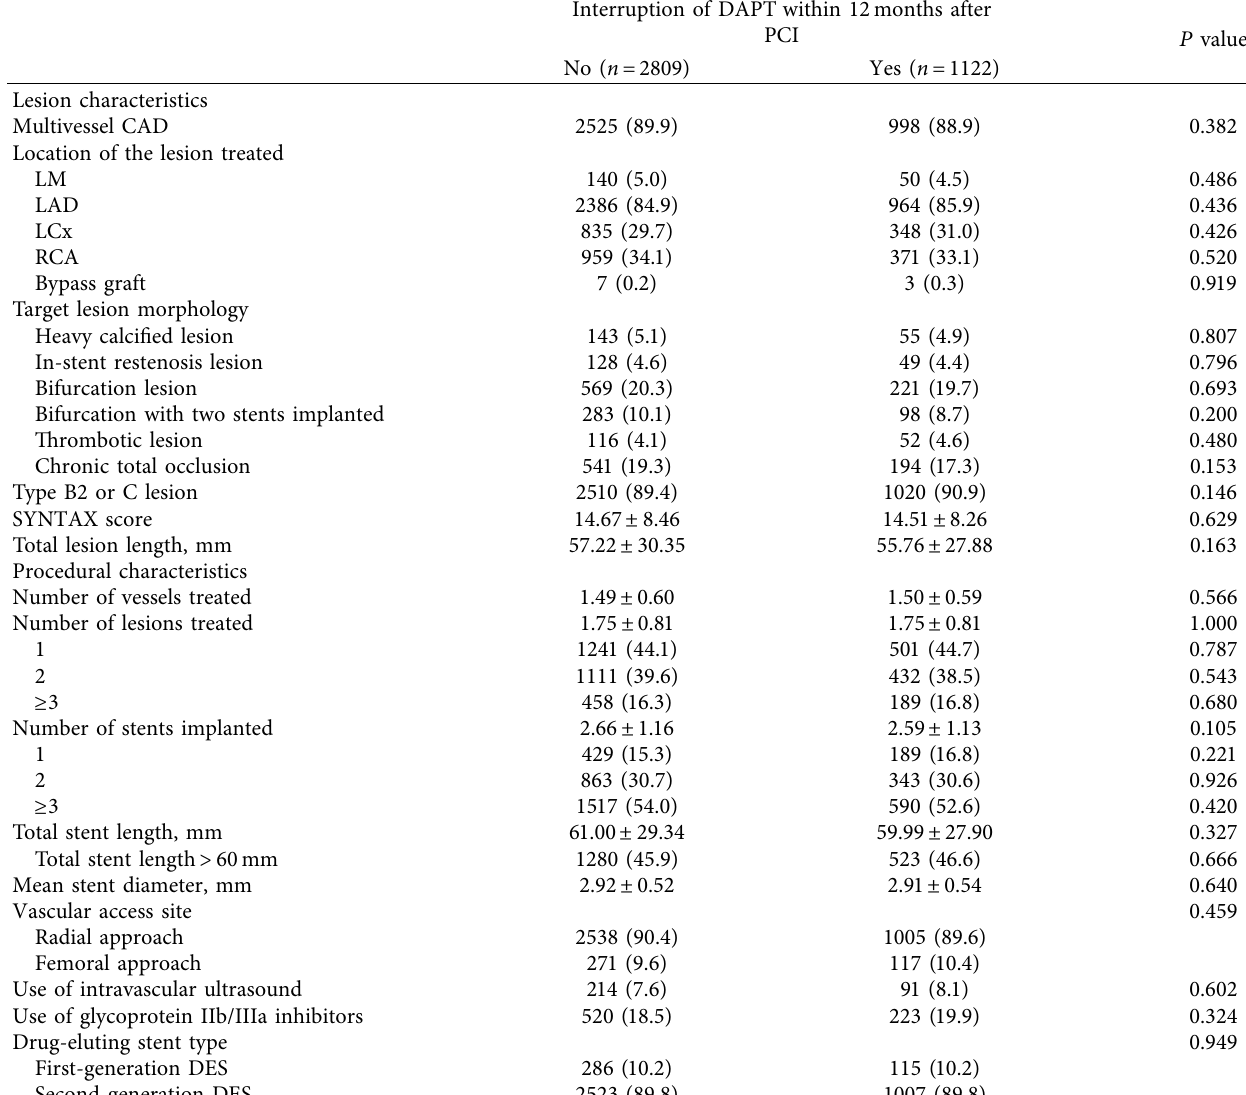
Table 3: Lesion and procedural